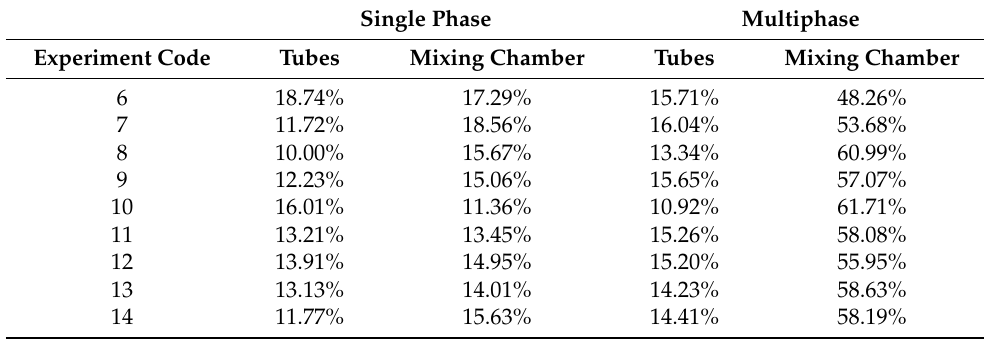
Table 7. Pressure drop contributions.